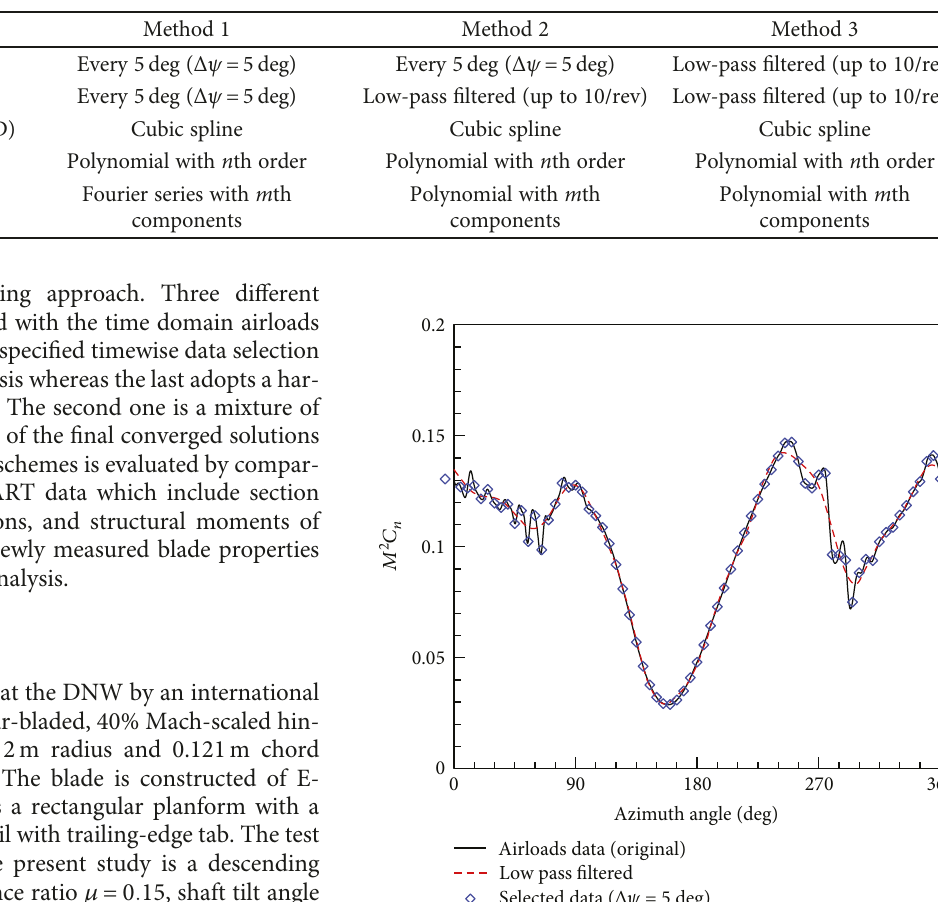
Figure 4: Blade elastic motions interpolated from CSD results. Table 2: Summary of data synthesis methods.